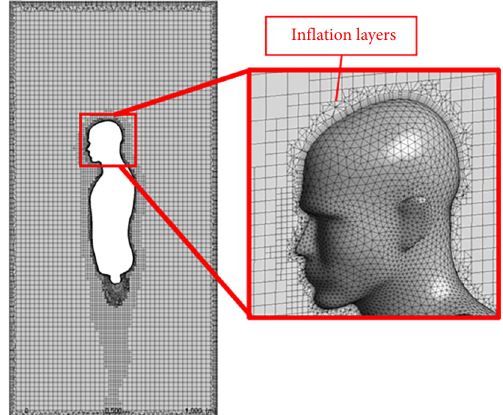
Figure 8. Computational mesh on a vertical plane and person. Total cell count is 0.5×10 6